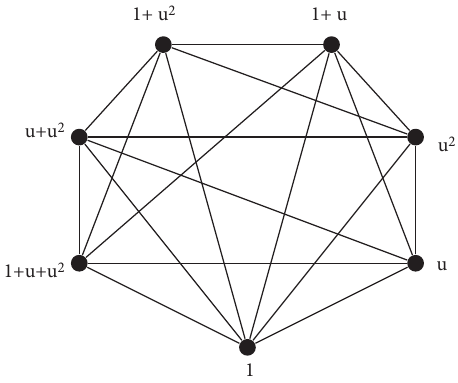
Figure 4: Quasiregular graphs of extension field F